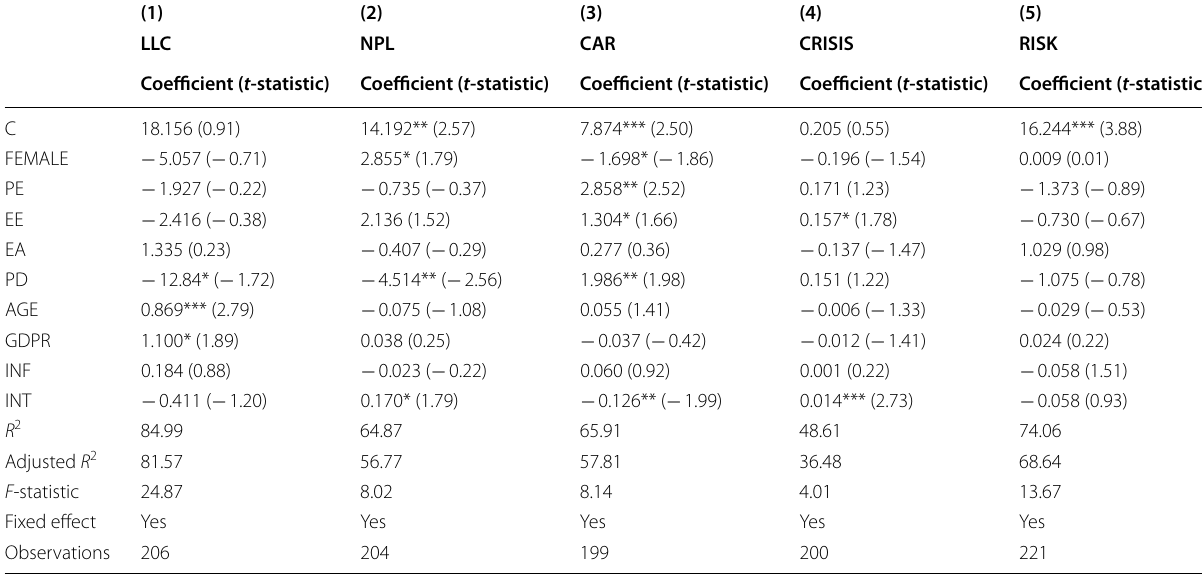
The results in this table are estimated using fixed-effect regression. Country and period fixed effect were